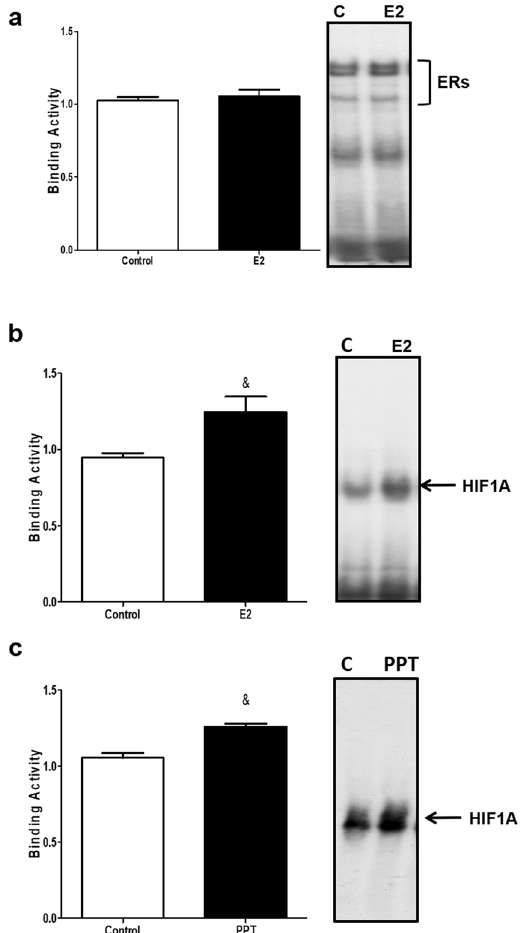
Figure 6. Effect of E2 on ERs and HIF1A binding activity to the Vegfa gene promoter. 3T3-L1 adipocytes were treated with vehicle (0.01% DMSO; Control); 10 nM of E2 or 10 nmol/L of PPT for 24 hours. EMSA was performed as described in Materials and Methods. ( a ) ERs, biding in VEGFA promoter after 24 hours of E2 treatment. ( b ) HIF1A biding in VEGFA promoter after 24 hours of E2 treatment; ( c ) HIF1A binding in VEGFA gene promoter after 24 hours of PPT treatment. Representative images of the experiments are in the right. Results represent three independent experiments. Data are shown as the mean ± SEM of 4 to 6 samples. & P < 0.05 vs